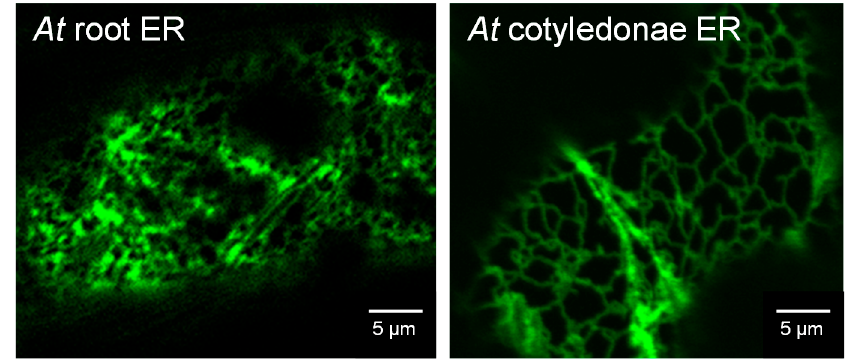
Figure 8. Structure of the endoplasmic reticulum (ER) in arabidopsis root and cotyledonae. Confocal images of ER in arabidopsis root and cotyledonae seven days after germination. Arabidopsis transformed in a stable manner, with the ER lumenal marker GFP-HDEL (green fluorescent protein fused to an ER retention signal consisting of the four amino acids Histidine-Aspartic acid-Glutamine-Leucine) used to visualize the ER.